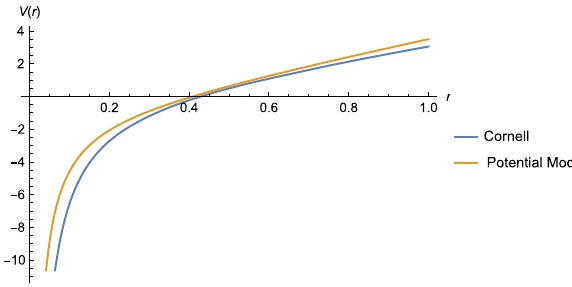
Fig. 2 Comparison of Cornell potential and potential model of this work. V ( r ) is in GeV and r in fm